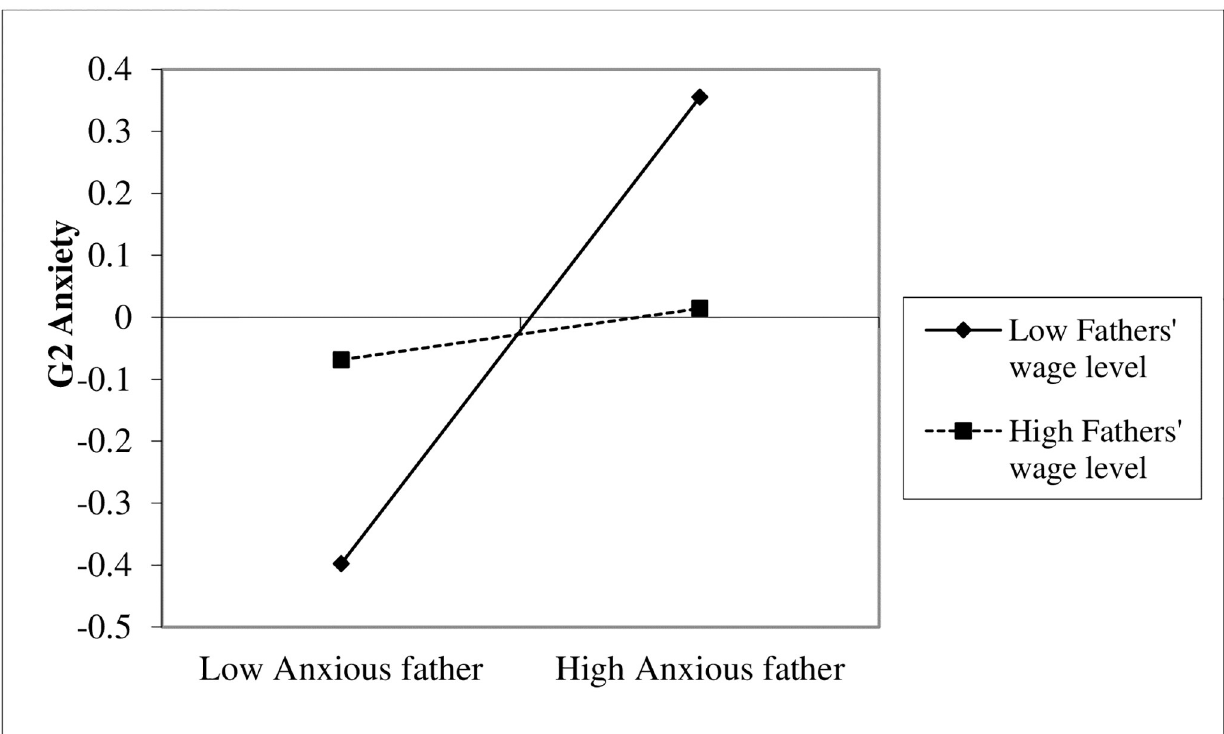
Fig 2. G1 fathers’ anxiety effects on G2 anxiety for low and high fathers’ wage